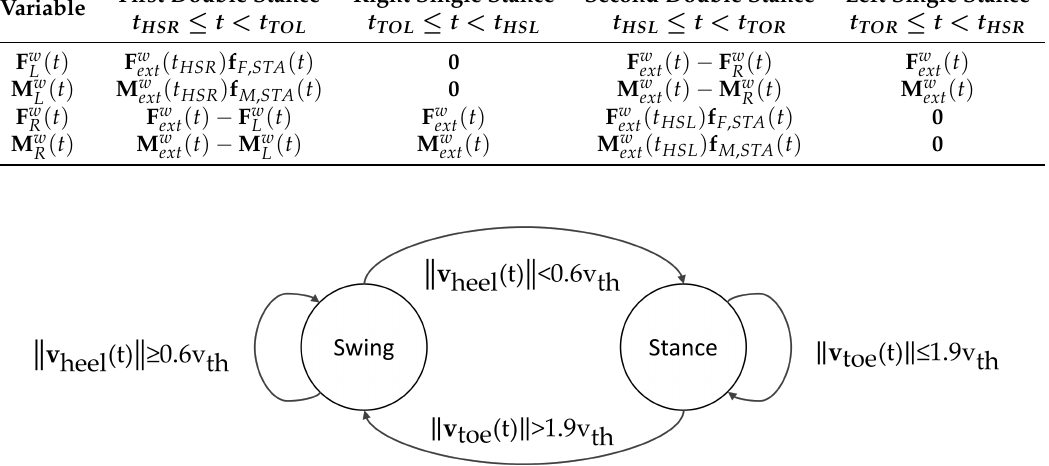
Figure 3. The curves of the smooth transition assumption function for the three GRF components ( f F , STA , three graphs on the top) and three GRM components ( f M , STA , three graphs on the bottom) used to distribute the total external force and moment among the two feet. Figure illustrates the curve of the GRF&Ms of the right foot between the events of left heel strike and right toe off (second double stance phase) expressed in the coordinate system defined by the walking direction. Continuous lines indicate the curves obtained from the average values across all subjects and trials of our dataset, whereas dashed lines indicate the curves proposed by Ren et al. [19]. Table 2. The calculation of the left and right GRF&Ms for each phase of the gait cycle. During single support, the GRF&M of the limb in contact with the ground is equal to the result of the Newton–Euler calculation ( F w , M w ), whereas during the double support phase, this result is distributed among legs ext ext based on the gait-event-dependent three-dimensional smooth transition assumption functions for the forces ( f F , STA ( t ) ) and moments ( f M , STA ( t ) ). Variable